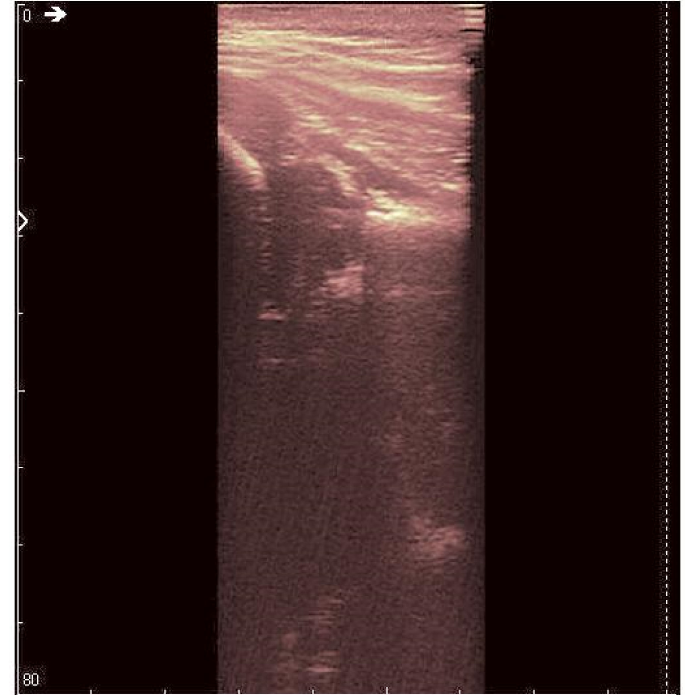
Figure 12. Denoising result for Image